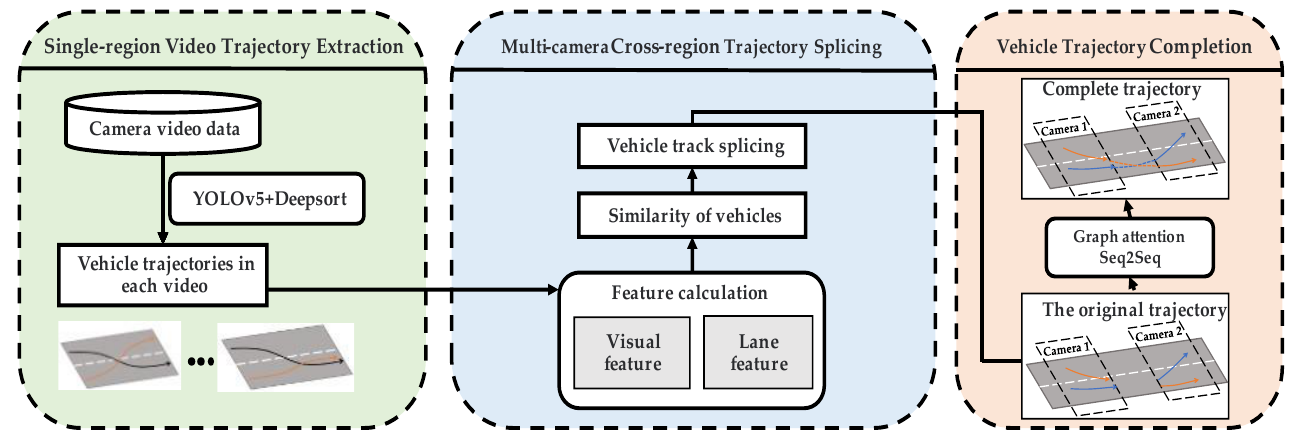
Figure 1. The framework for continuous vehicle trajectory reconstruction based on video data.